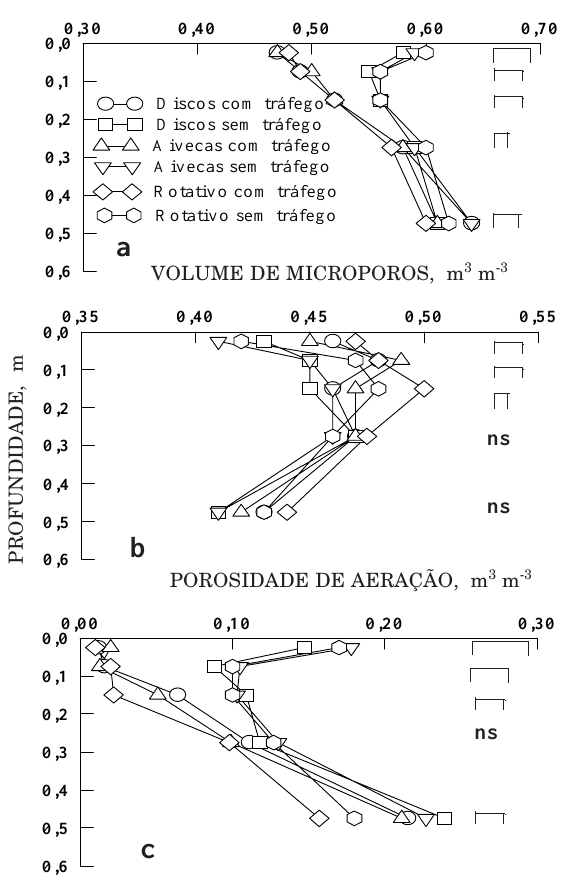
Figura 2. Porosidade total (a), volume de microporos (b) e porosidade de aeração (c) do solo obtidos na amostragem realizada em março de 1990. (As barras horizontais indicam as diferenças mínimas significativas entre os tratamentos obtidas pelo teste de Tukey (p < 0,01) e ns